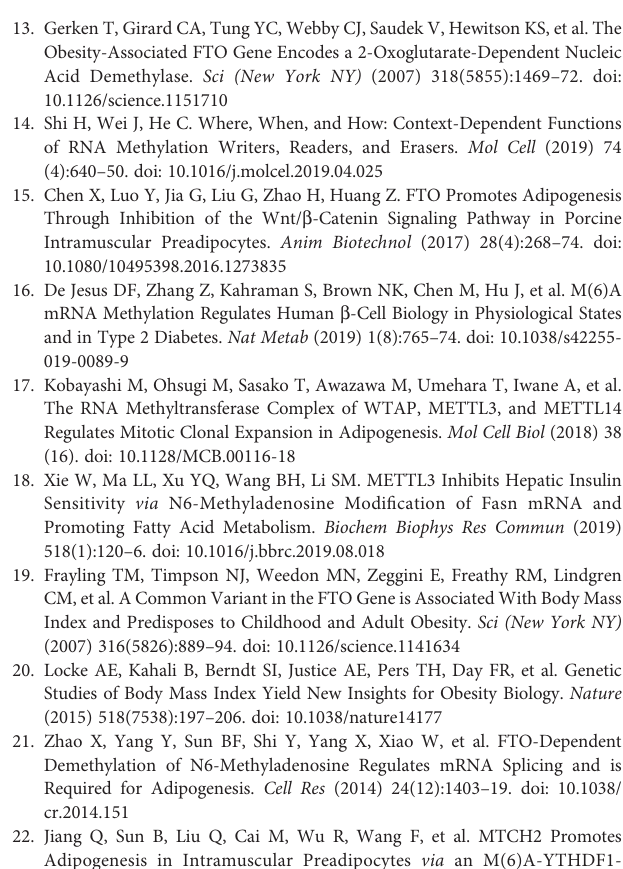
Supplementary Table 1 | Primer sequences used for RT-qPCR analyses. Supplementary Figure 1 | Heatmap matrix of pairwise linkage disequilibrium. Heatmap matrix of pairwise linkage disequilibrium statistics (r2 and D´) of SNP markers in (A) the YTHDF3 locus and (B) the METTL3 locus.The fi gure was created by using “ LDlink – An interactive webtool for exploring linkage disequilibrium